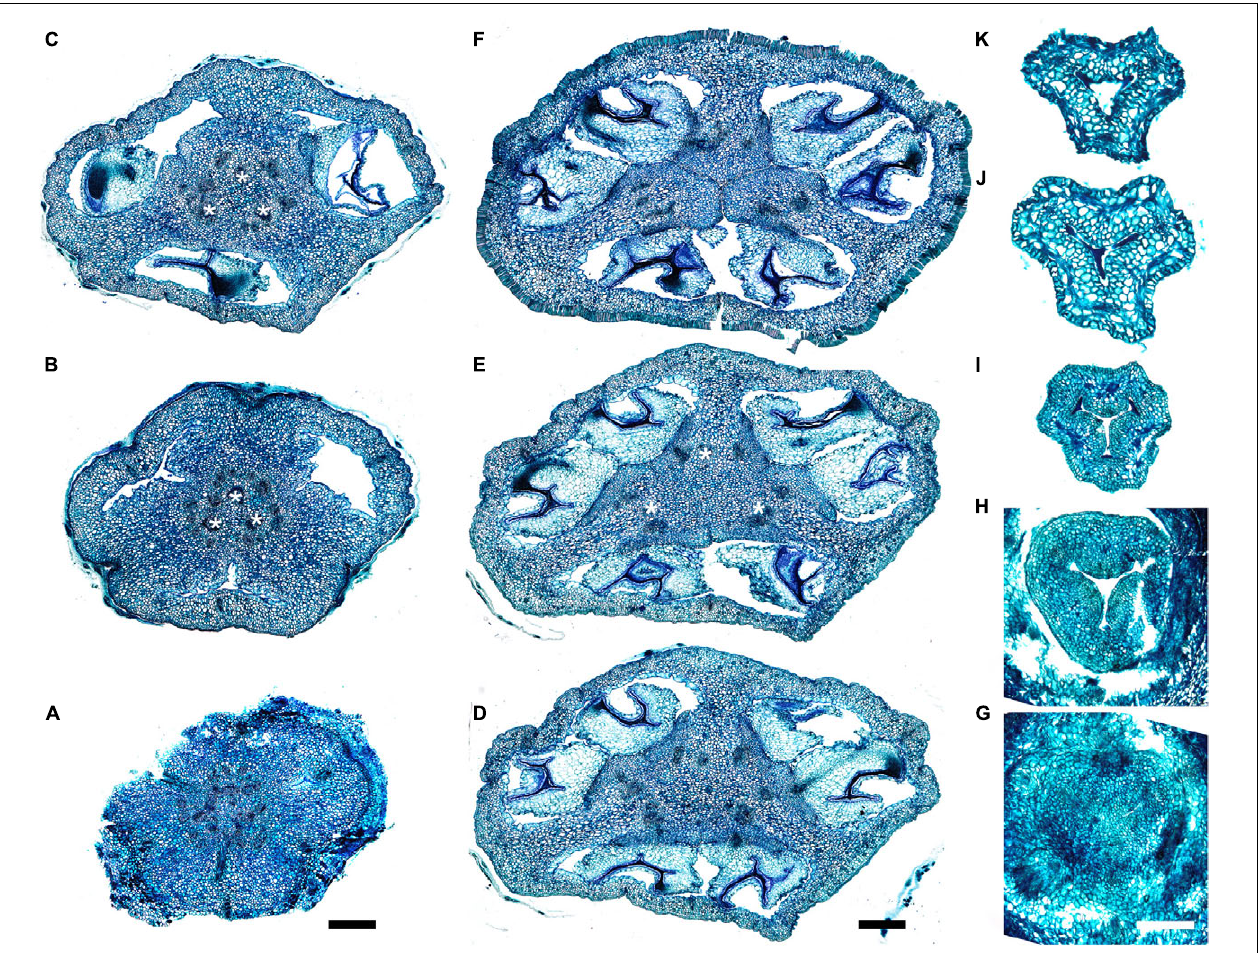
FIGURE 8 | Gynoecium of Saxofridericioideae-Schoenocephalieae. Kunhardtia rhodantha . (A–F) Ovary of anthetic flower. (A) Receptacle below ovary. (B) Basal part of synascidiate zone. (C) Distal part of synascidiate zone. Note secretion around ovary in panels (B,C) . (D) Transition to symplicate zone. (E,F) Symplicate zone. (G–K) Gynoecium of flower bud at stage before ovule initiation. (G) Just initiated synascidiate zone, future ovary. (H,I) Symplicate zone, future ovary. (J,K) Symplicate zone, future style. *, synventral bundle. Scale bars = 400 mkm in panels (A–F) and 50 mkm in panel (G–K) .